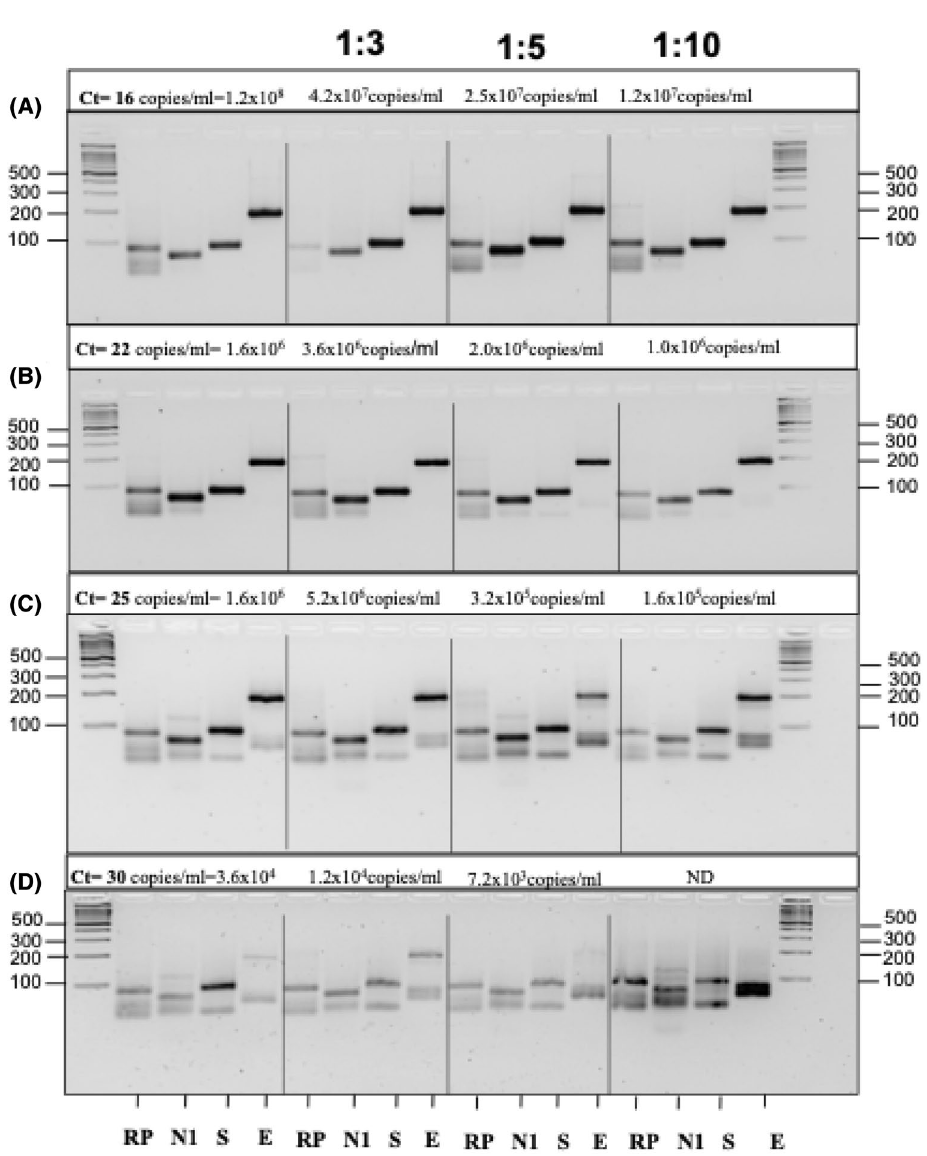
Figure 3. End-point PCR showed a high detection limit when analyzing samples with a positive qRT-PCR diagnosis. All samples in the study had known Ct values that were used to determine viral copy numbers. ( A – D ) Increasing Ct values in samples were correlated with lower viral loads. ( D ) The positive sample with a Ct value of 30 corresponded to a detection limit of 7 viral copies/µl (1:5 dilution). At lower dilutions, the virus fragments were no longer detectable, and nonspecific bands of human genomic bulk were